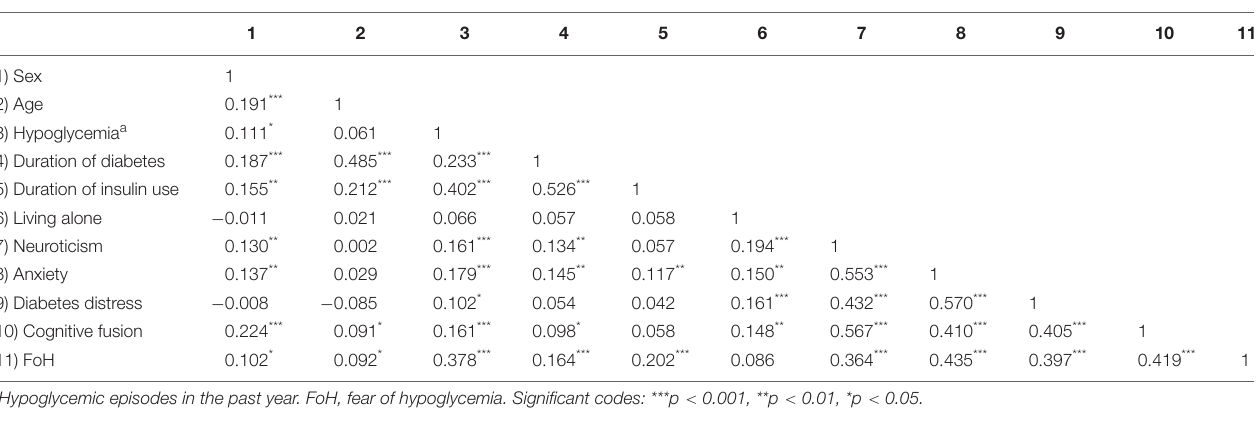
TABLE 3 | Spearman’s correlation matrix of the variables of interest.